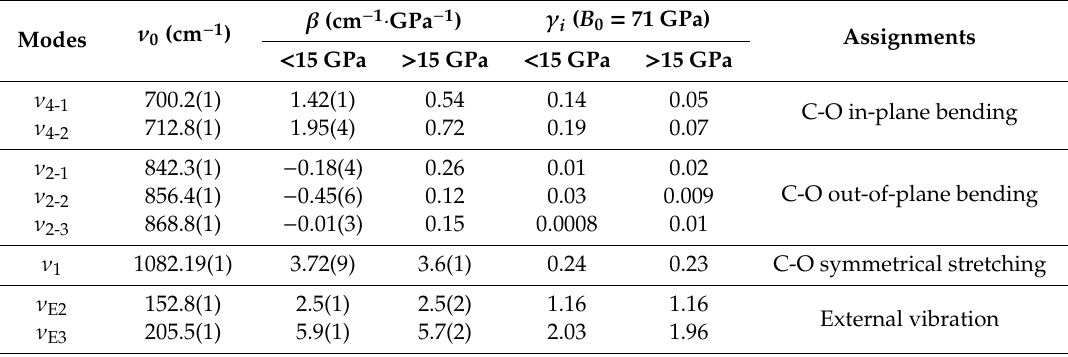
Table 4. Vibrational modes for aragonite, their pressure dependences β and the calculated mode Grüneisen